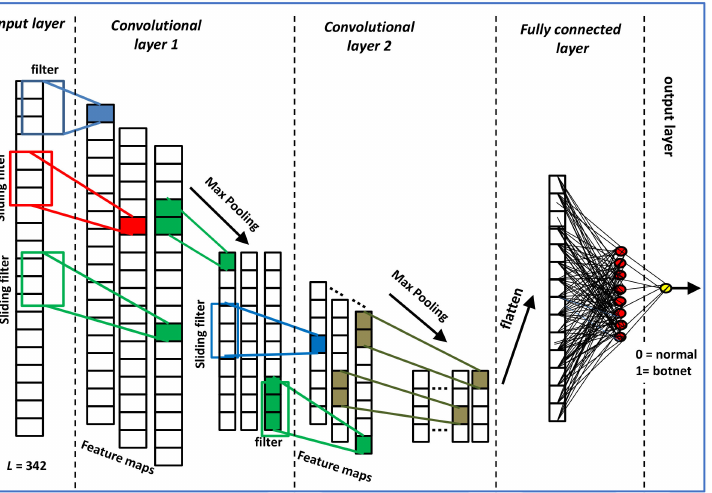
Figure 2. 1D CNN model with 2 convolutional and max pooling layers feeding a dense (fully connected) layer. The model is designed for botnet detection by classifying Android applications into ‘normal’ or